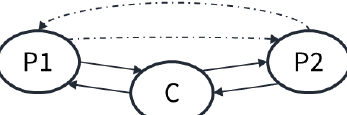
Figure 5. Structure of a connection with two ports in a block/model.